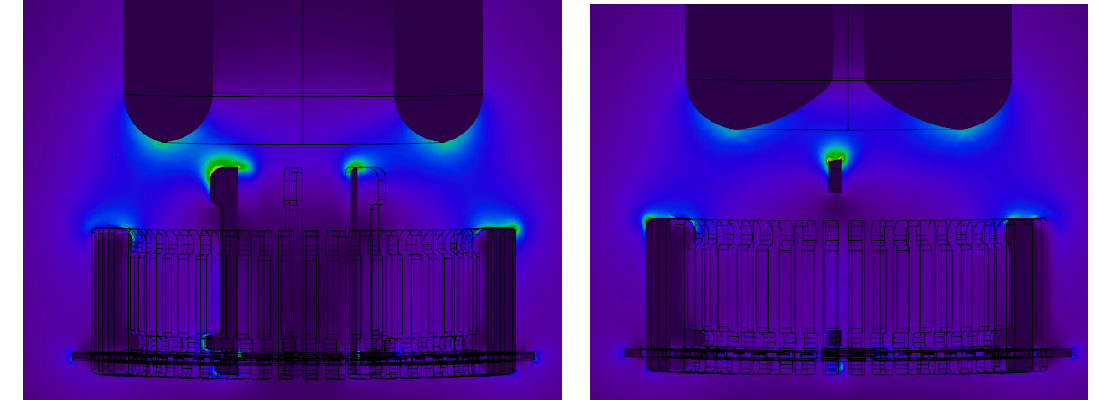
Figure 25. Electric field intensity distribution of large lamellas ( V/m ).